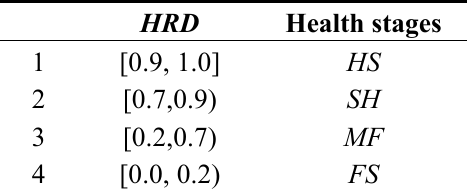
Table 1. Relationship between HRD and health degradation